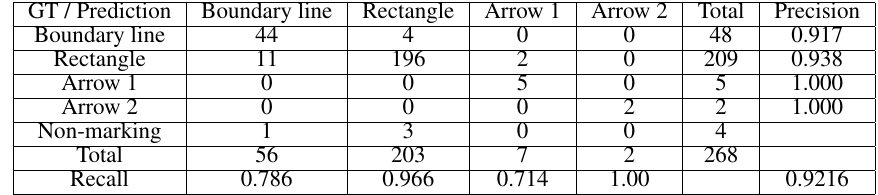
Table 2. Confusion Matrix for road markings classification for Highway 2 dataset